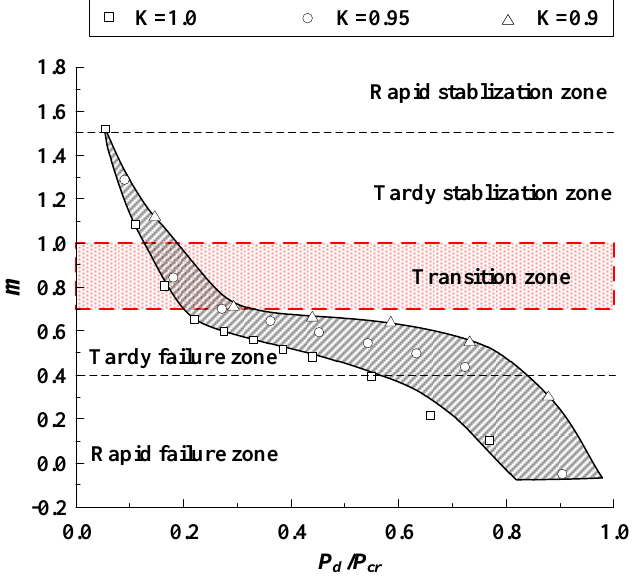
Figure 17. Classification of different evolving states according to the relationship between m and P d / P cr.